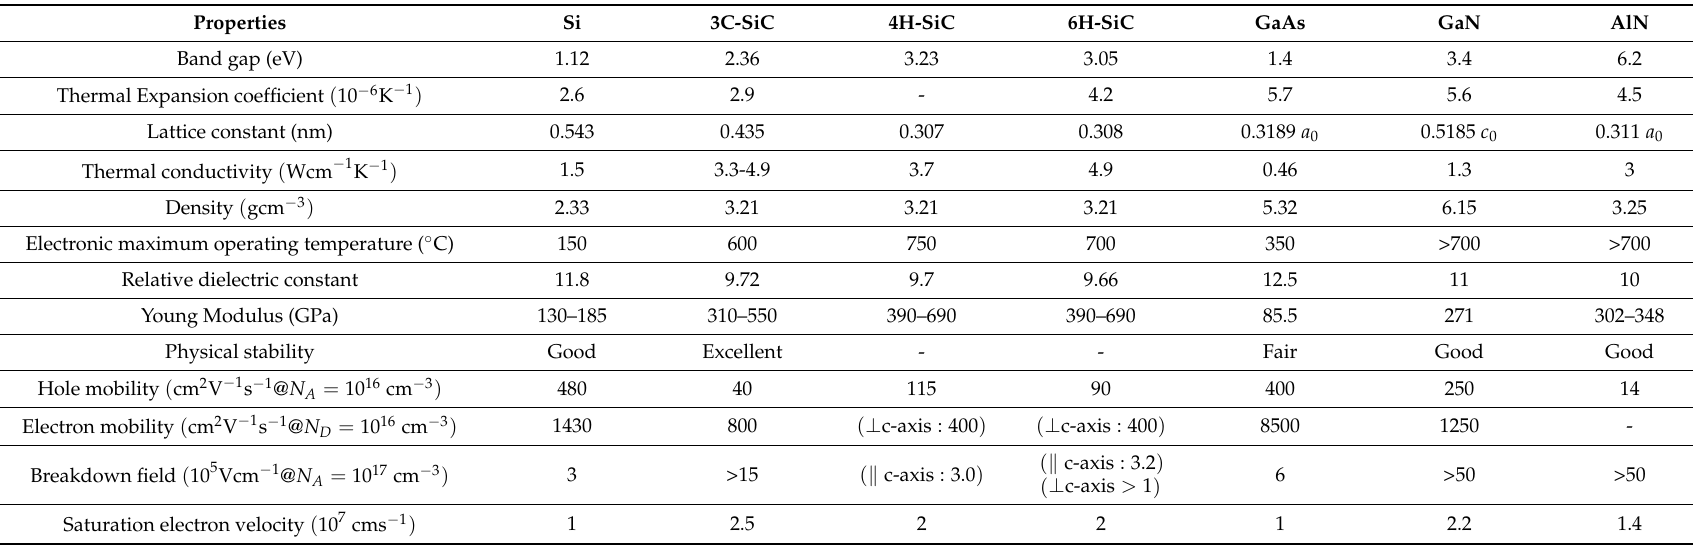
Table 3. Material properties of various semiconductors for high temperature applications (adapted and updated from [26,60,81]).